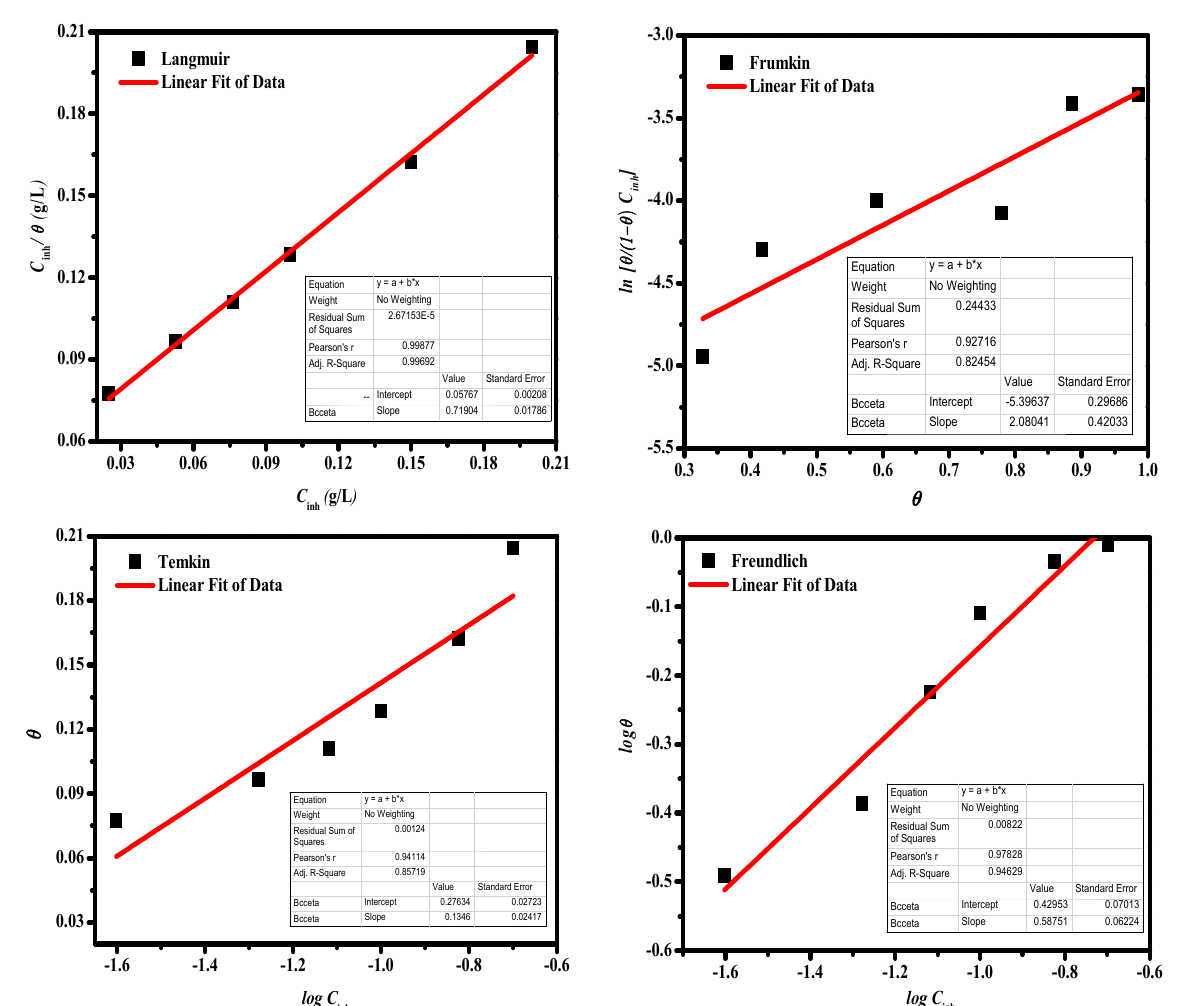
Figure 8. Four different adsorption isotherms for MS alloy immersed in HCl/NaCl medium and containing various concentrations of ZnNiO@PANE at 298 K.